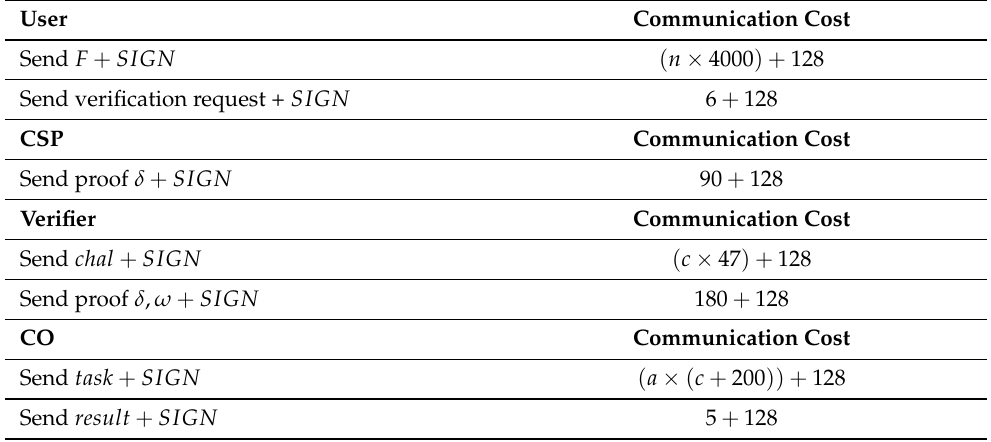
Table 4. Communication costs of each actor.